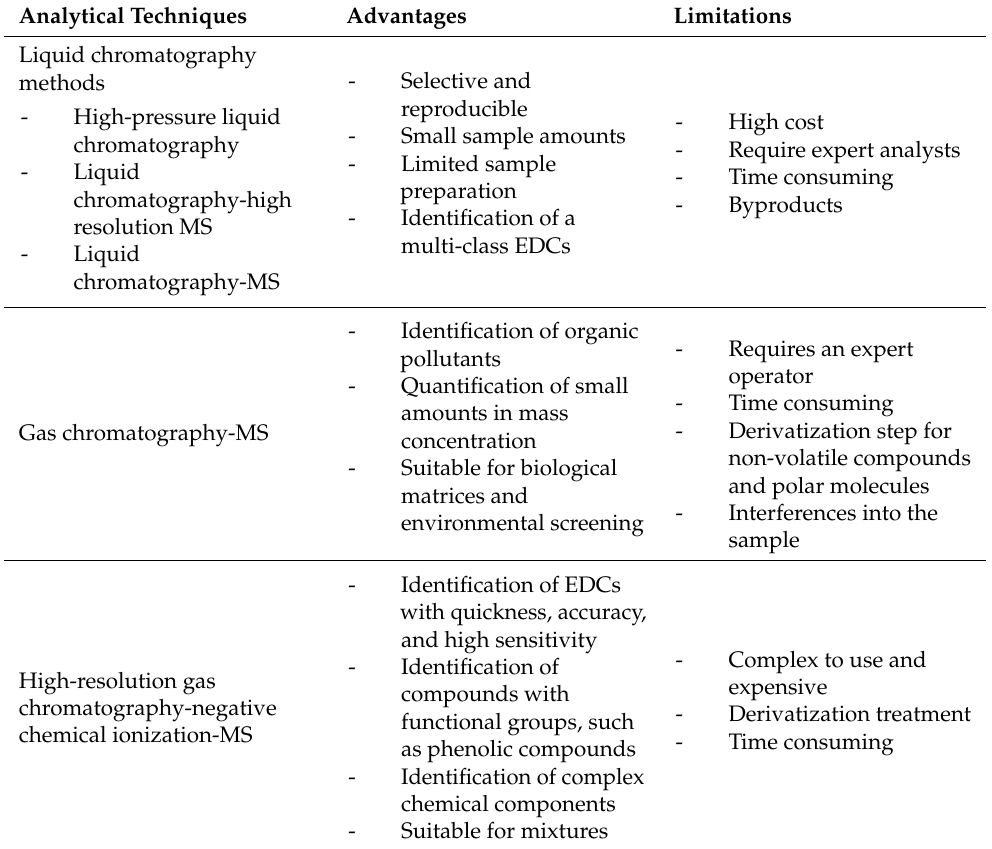
Table 2. Characteristics of the main analytical methods for EDCs’